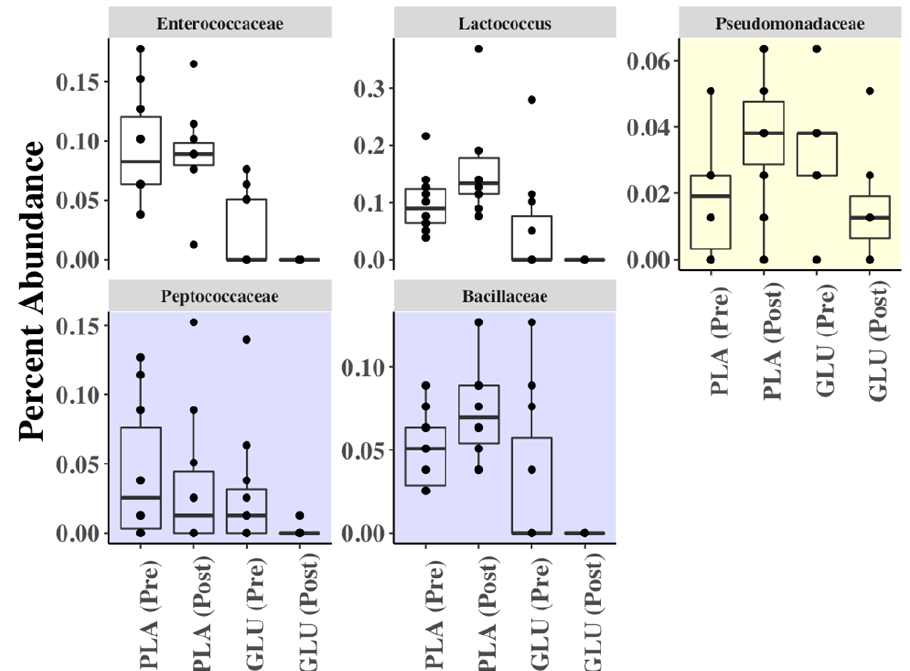
Figure 5. Bacterial taxa present in significantly different proportions in fecal contents before and after PLA and GLU supplementation. The white background for Enterococcaceae and Lactococcus indicates that these taxa were present in significantly different proportions between PLA and GLU (PRE). The yellow background for Pseudomonadaceae denotes a significant difference between GLU (Pre) and GLU (Post). The purple background for Peptococcaceae and Bacillaceae denotes a significant difference for GLU (Post) compared to GLU (Pre) as well as to both PLA (Pre) and PLA (Post). Taxa were compared using MaAsLin ( p < 0.05).